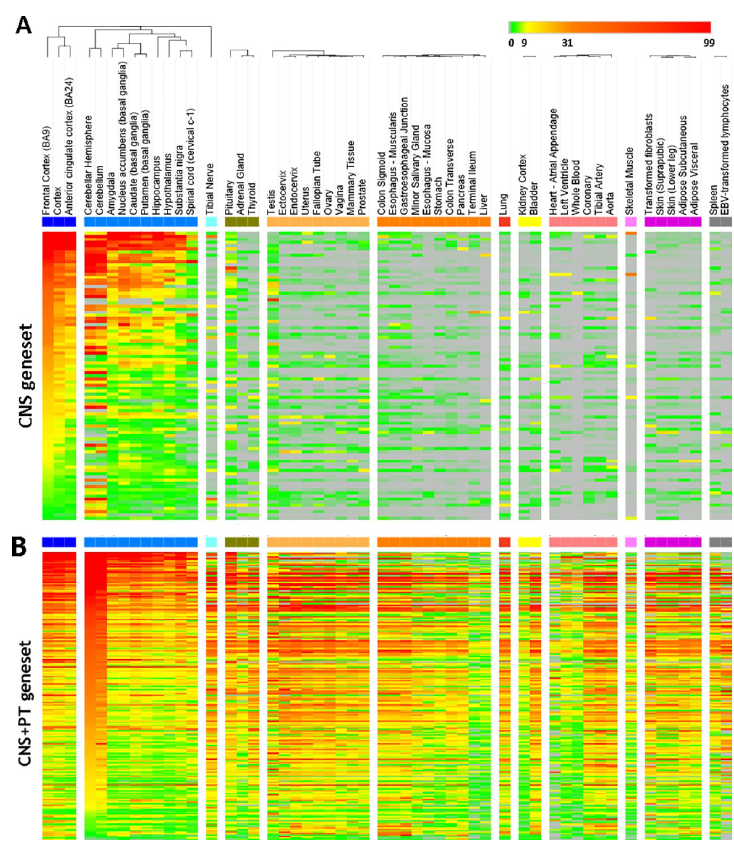
Fig 3. Heatmap of 292 genes after filtering for low expressed genes (TPM < 3). The tissues were indicated on the top. Scale bar on top right corner showed the scale of mRNA expression for each gene: grey is TPM = 0, green is 0–3, yellow is 9–31, orange is 31–99, red is > 99. (A) The 91 genes in the CNS geneset have an average median of TMP < 3 in the peripheral tissues. (B) The 201 CNS+PT genes were expressed both CNS and peripheral tissues with TMP >